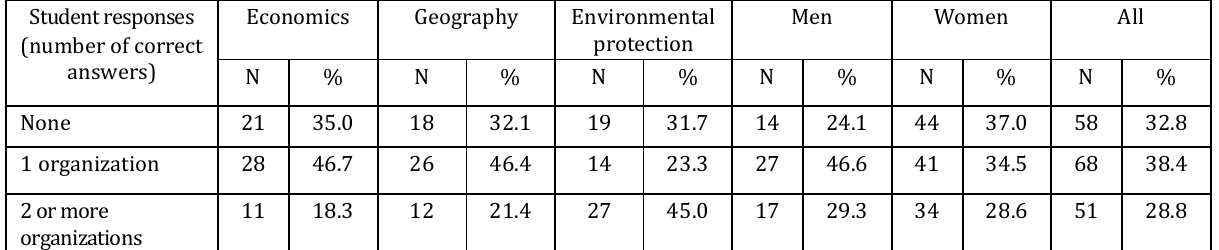
Table 3. The responses of the students to the question 6 - "Please select which categories of these are protected areas of Poland?" Student responses (correct or incorrect) Correct Incorrect Table 4. The responses of the students to the question 8 - "Please list all the Environmental Organizations you know" Student responses (number of correct